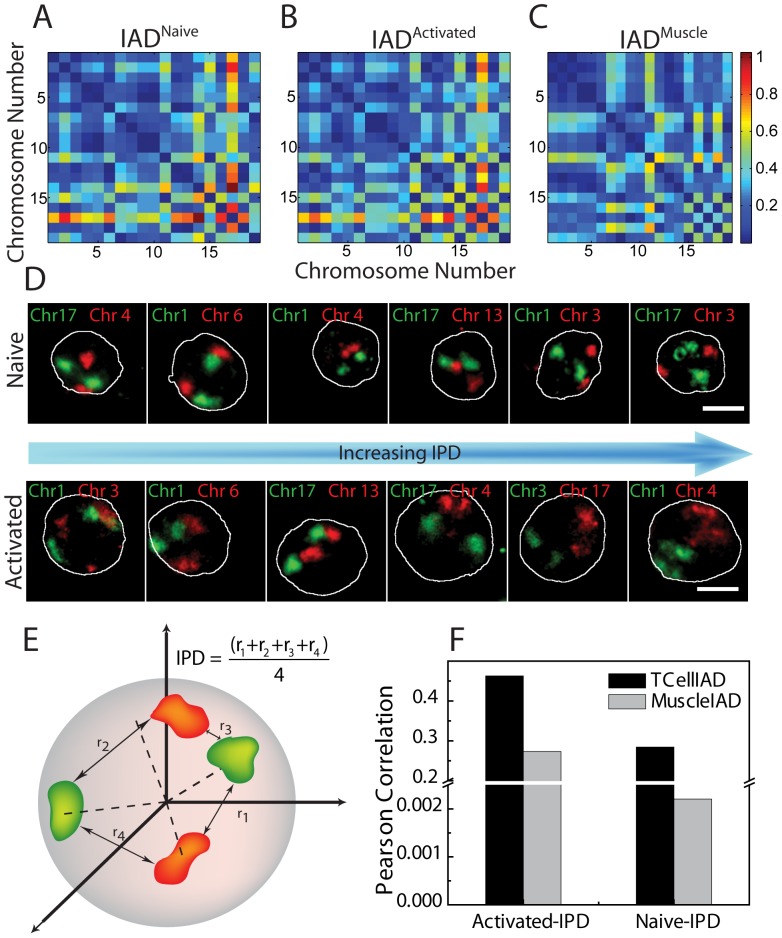
Experimental validation of the coupling between spatial organization and activity in Mouse T cells.(A) IADNaive matrix for murine naïve T cells. (B) IADActivated for activated T cells. (C) IADMuscle for muscle cells. (D) Representative images of different pairs of chromosomes (red and green) in naïve (upper panel) and activated T-Cells (lower panel) with DNA in blue, scale bar ∼5 µm. The chromosome pairs are arranged in increasing order of mean IPD values. (E) Schematic depiction of estimating the mean IPD from the four minimum distances between the interfaces of the four homologues of a pair of chromosomes. (F) Pearson correlation coefficients (PCC) computed for IAD of T cells or muscle cells with IPD of T cells.